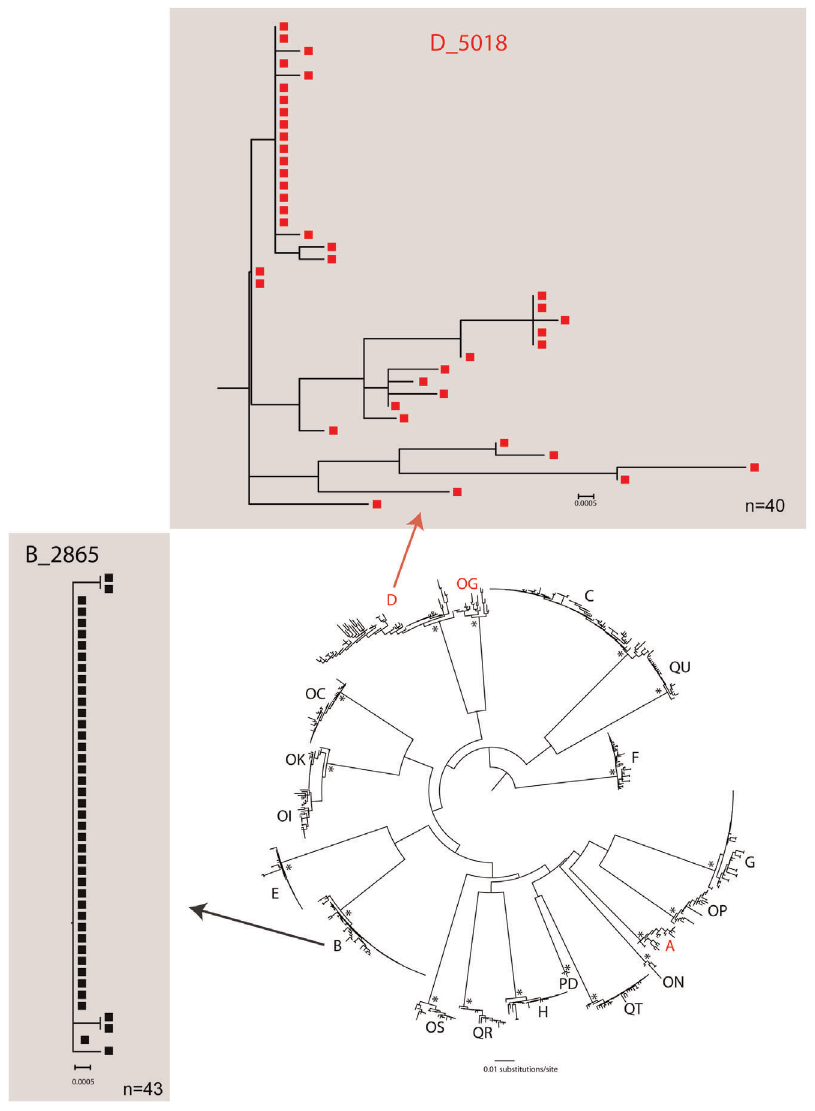
Figure 2. HIV-1 subtype C phylogenetic relationship and diversity of HIV non-structural genes is consistent with the multiplicity of HIV-1 infection determined by analysis of the env / gag genes. A maximum likelihood phylogenetic tree was reconstructed using Fastree2 (Price et al ., 2010) using the GTR + G model for nucleotide substitution and visualized in Figtree v.1.1.3 [54]. Alternative likelihood ratio tests [55] . 0.95 are shown by an asterisk. Subjects infected with multiple viral variants are colored red. Patient B and D subtrees (individual trees on grey background) show branching topology of earliest sampling (0–90 days p/s) and represent examples of single (subject B) and multiple (subject D) HIV-1